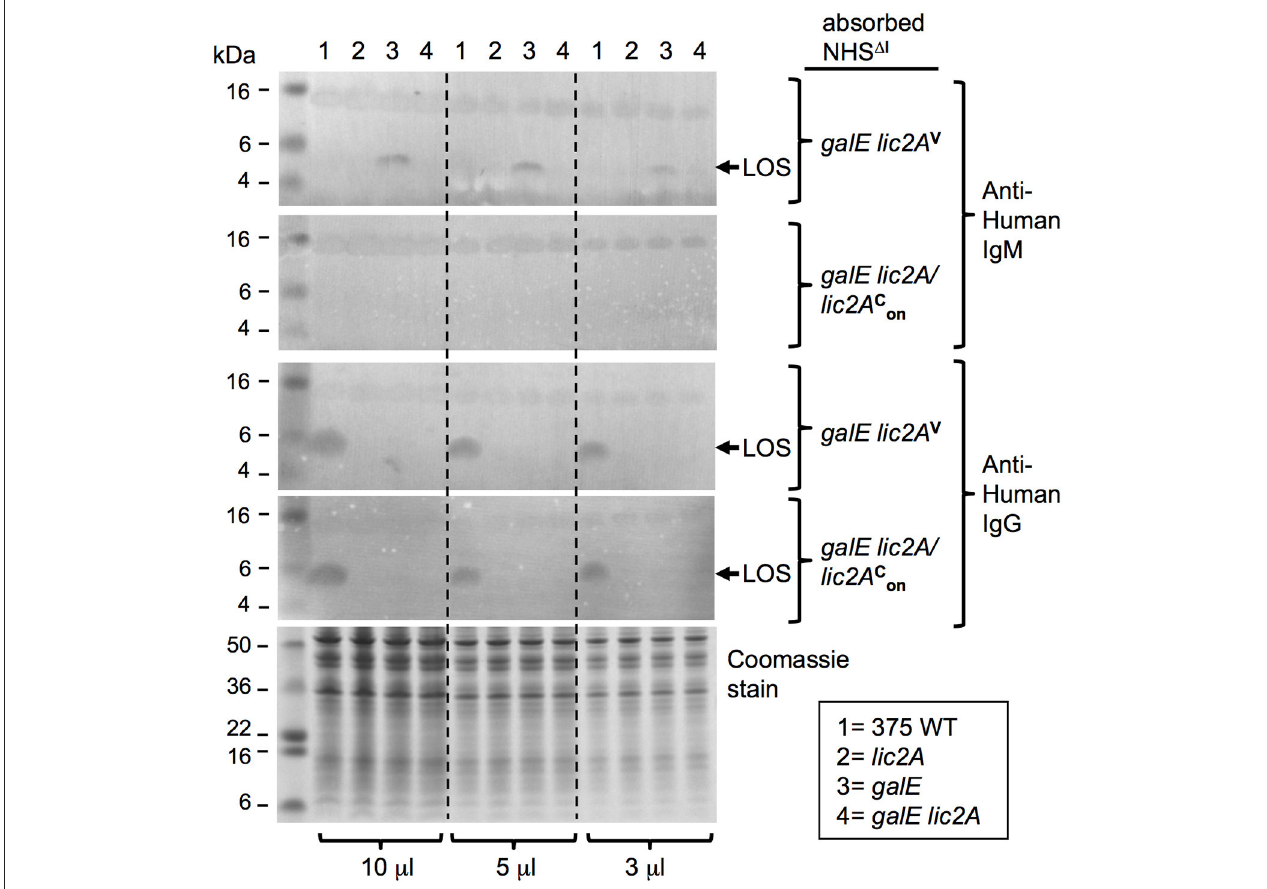
FIGURE 12 | IgM binding to a lic2A dependent LOS epitope in the galE mutant. Whole-cell lysates from NTHi 375 and the indicated isogenic mutants grown on MIc SA were digested with proteinase K and separated by NuPAGE 4–12% Bis-Tris gels followed by western immunoblotting. Membranes were incubated with serum pre-absorbed with strains RdgalElic2A/lic2A C on (GalE − , Lic2A + ) or RdgalElic2A V (GalE − , Lic2A − ) followed by incubation with alkaline phosphatase conjugated anti-human IgM or IgG. Equal sample concentration was verified by Coomassie Blue staining of undigested samples. Each sample was electrophoresed at three different concentrations. Arrows indicate ∼ 5kDa LOS; pre-stained protein standards in left